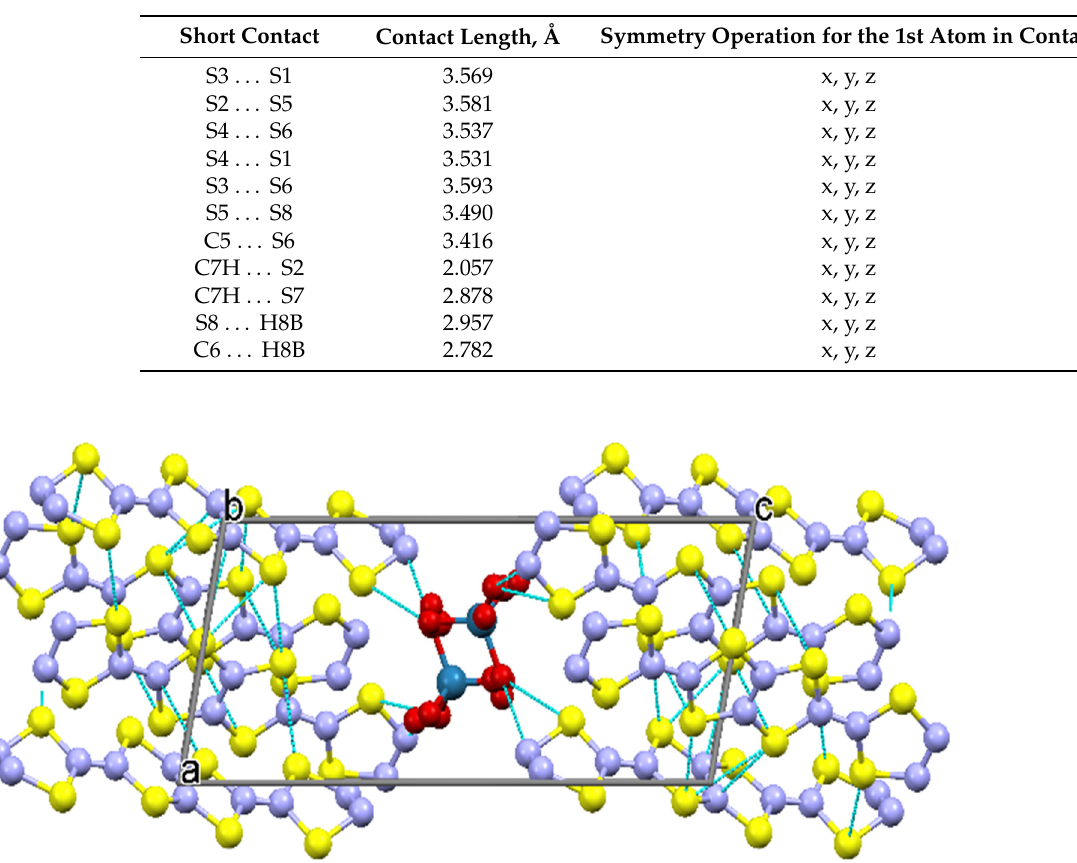
Figure 5. Projection of the crystal structure of the pseudo- κ″ -(BDH-TTP) 3 (ReO 4 ) 2 salt ( 3 ) on the ac plane; dashed lines show shortened intermolecular contacts between the BDH-TTP molecules.